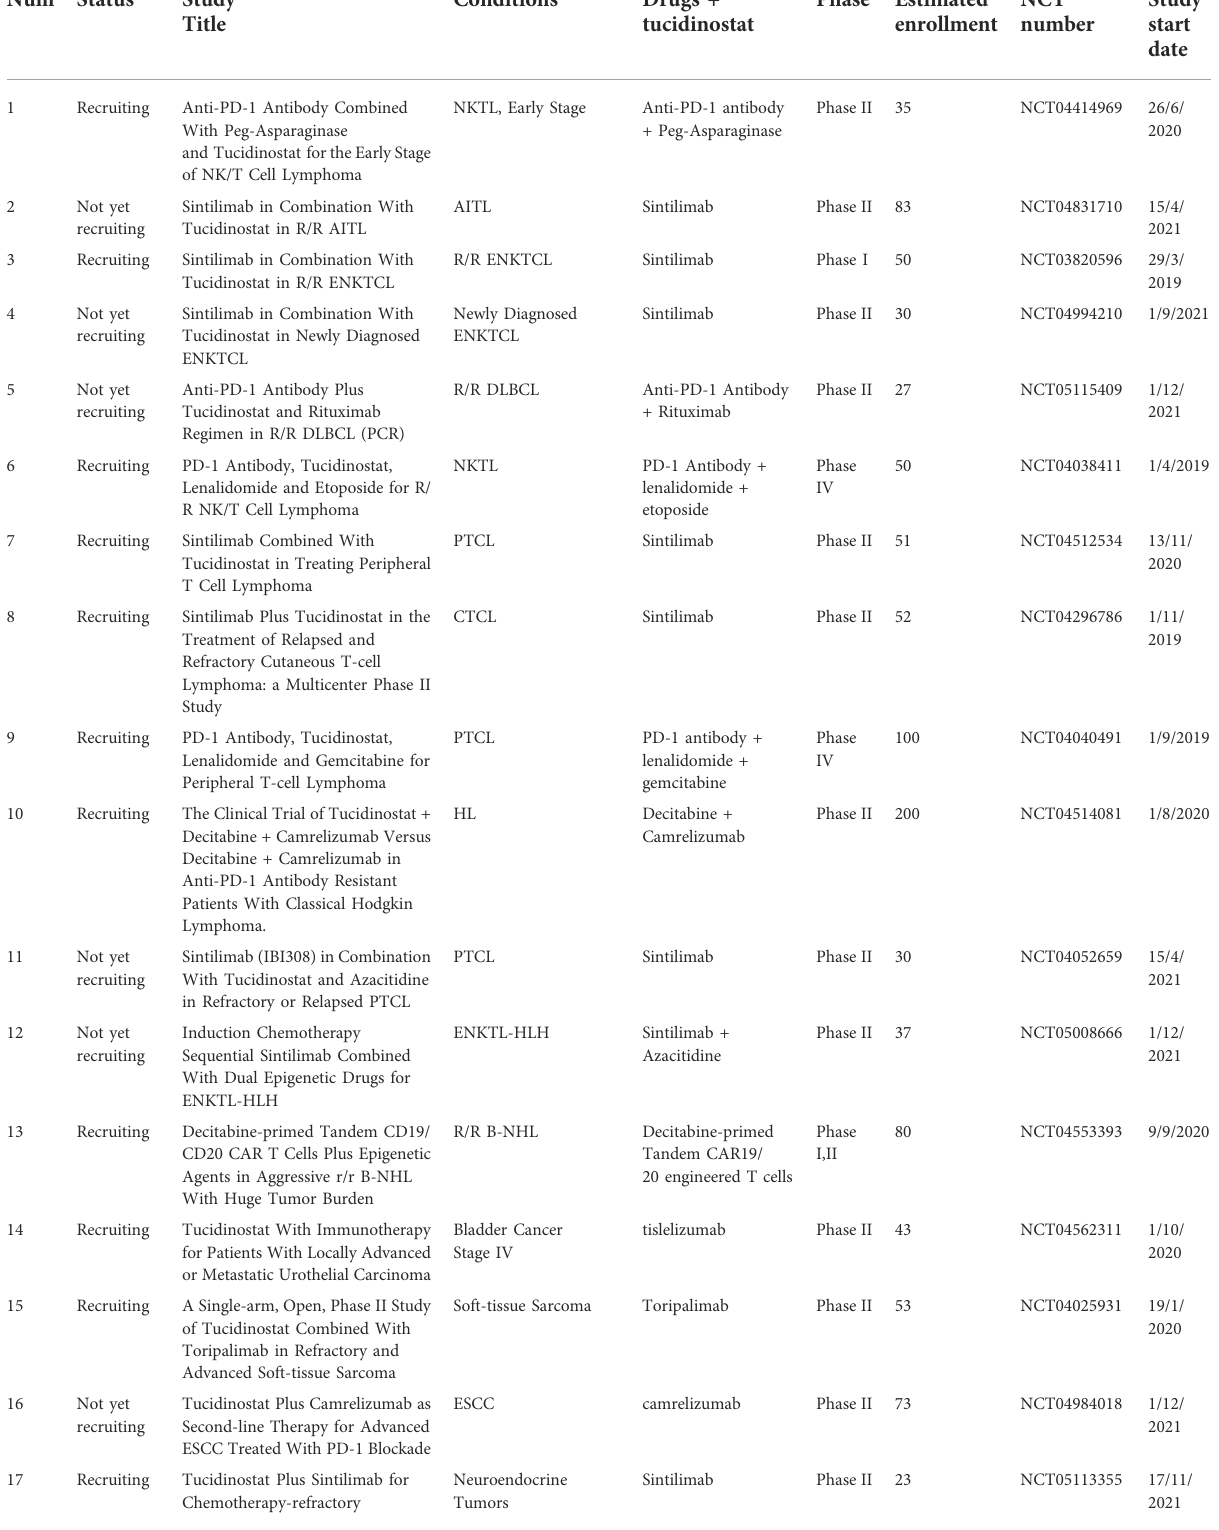
TABLE 5 Ongoing clinical trials of tucidinostat in combination with